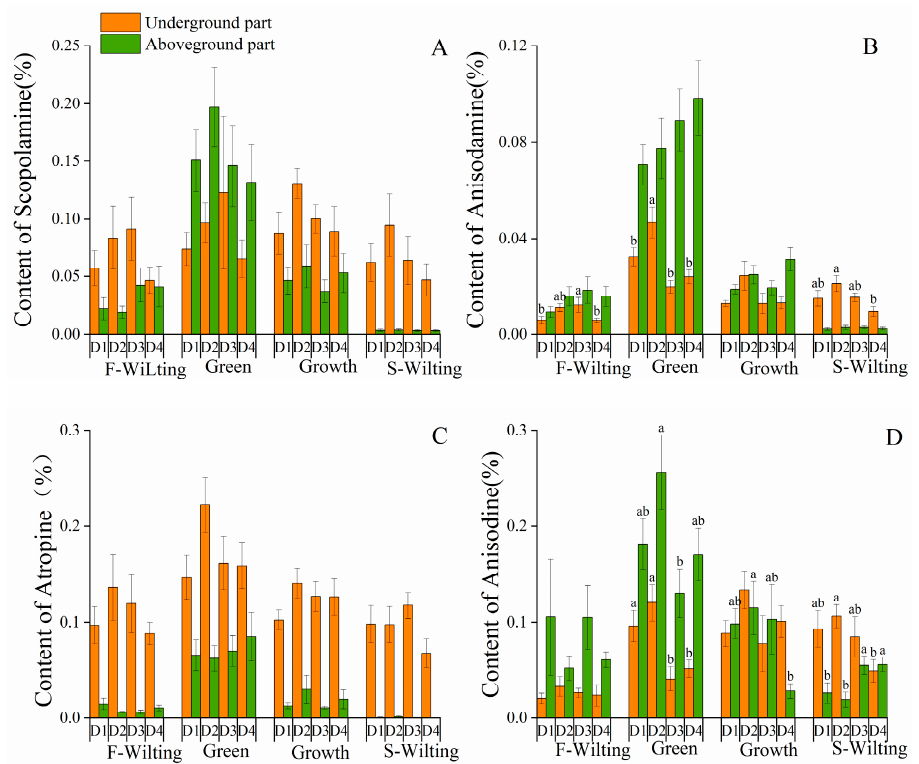
Figure 2. Alkaloid content under different density gradients(( A ) scopolamine; ( B ) anisodamine; ( C ) atropine, and ( D ) anisodine). Different letters indicate a significant difference between treatments at p < 0.05 level.